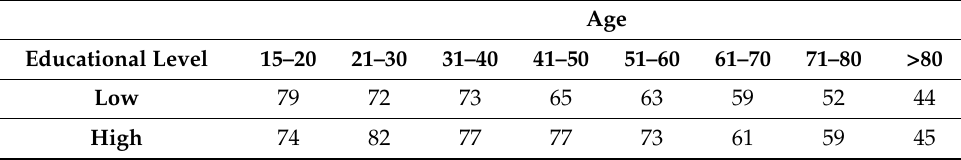
Table 1. Cut-off values of the Brief Neuropsychological Cognitive Examination (BNCE) results were adjusted for educational level and